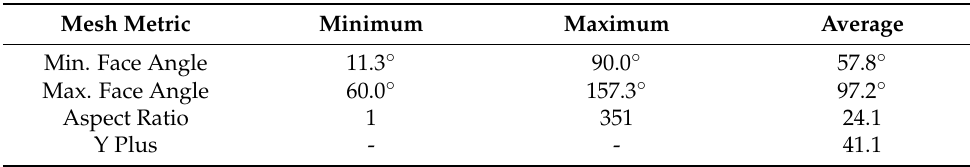
Table 2. Distributor mesh quality characteristics.